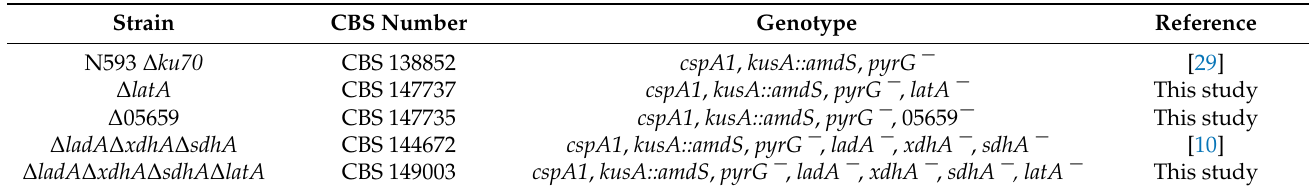
Table 1. A. niger strains used in this